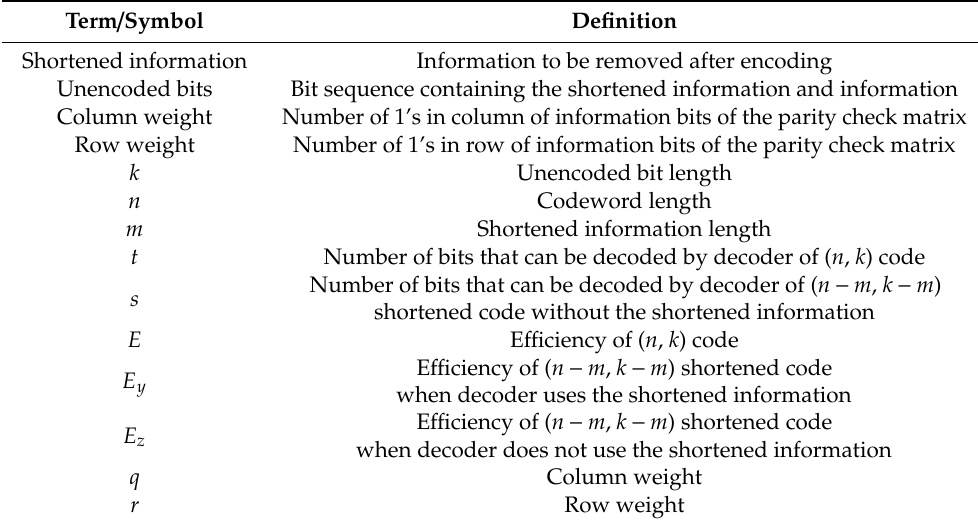
Table 1. Definitions of terms and symbols.